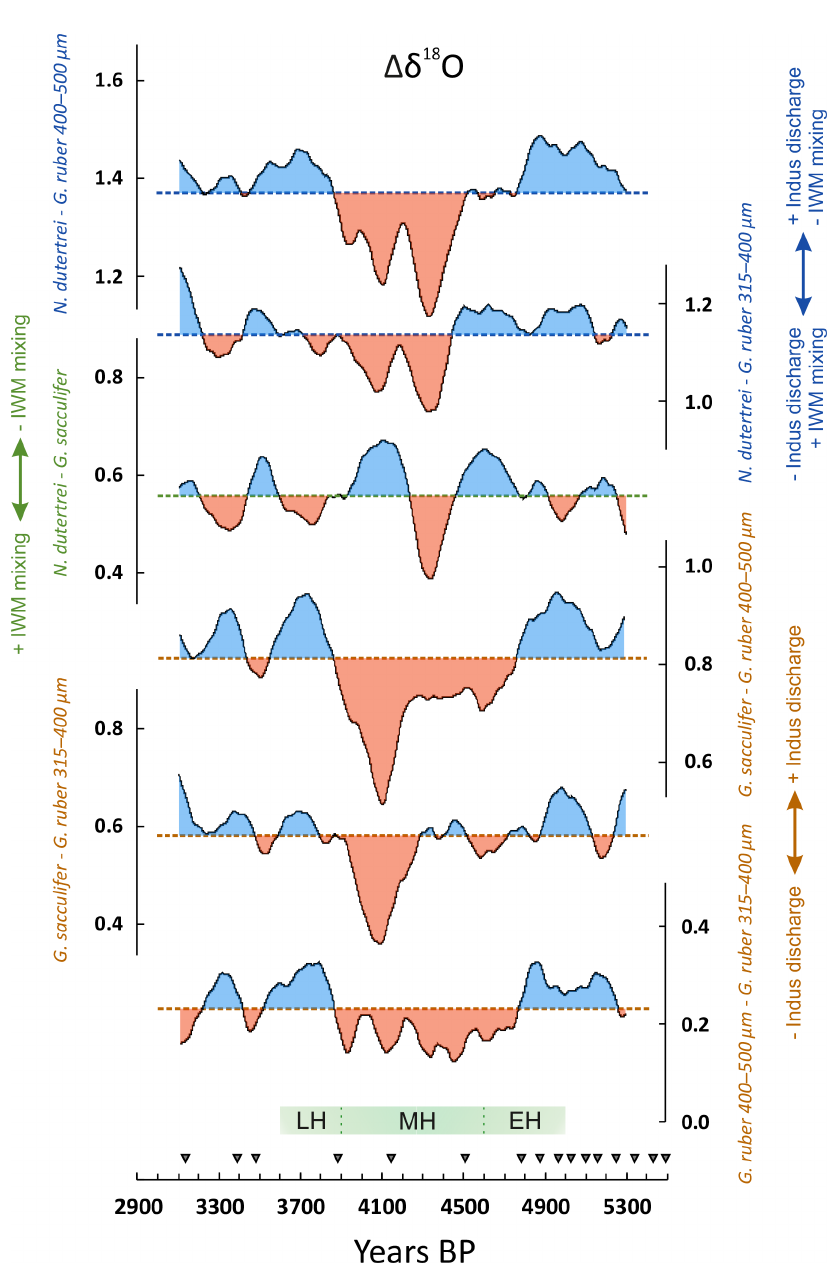
Figure 6. Core 63KA (cid:49)δ 18 O shown with a 210-year loess smoothing. Individual AMS radiocarbon dates are denoted by triangles near the timeline. G. ruber 315–400µm size fraction data come from Staubwasser et al. (2003). The green band near the timeline showing EH, MH, and LH refers to Early Harappan ( ∼ 5 . 0–4.6ka), Mature Harappan ( ∼ 4 . 6–3.9ka), and Late Harappan ( ∼ 3 . 9–3.6ka) periods,